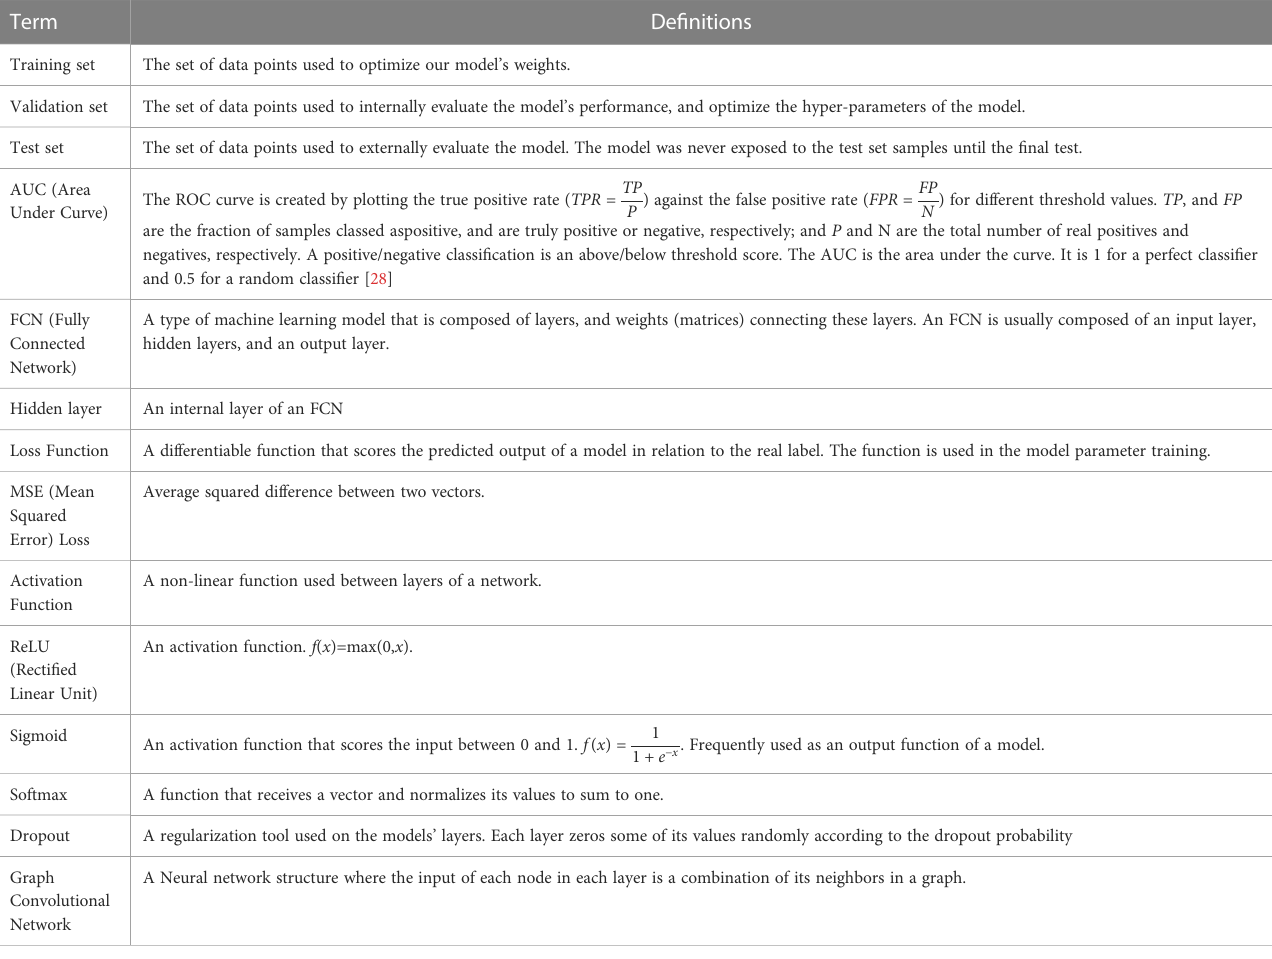
Sigmoid Softmax Dropout Graph